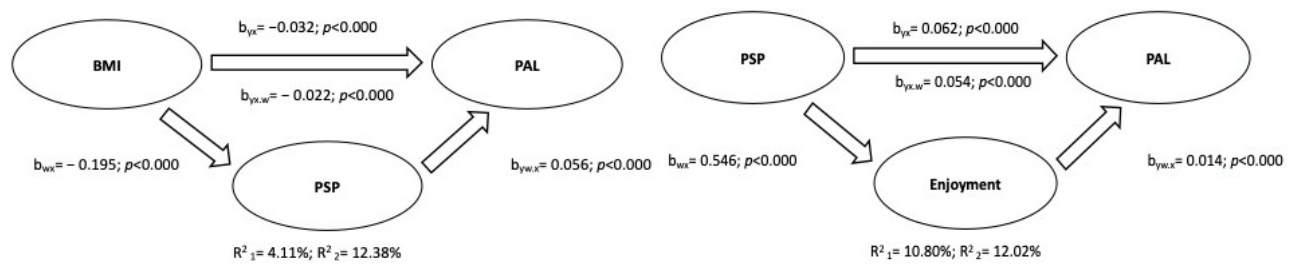
Figure 6. Mediation Analysis of Total Sample.